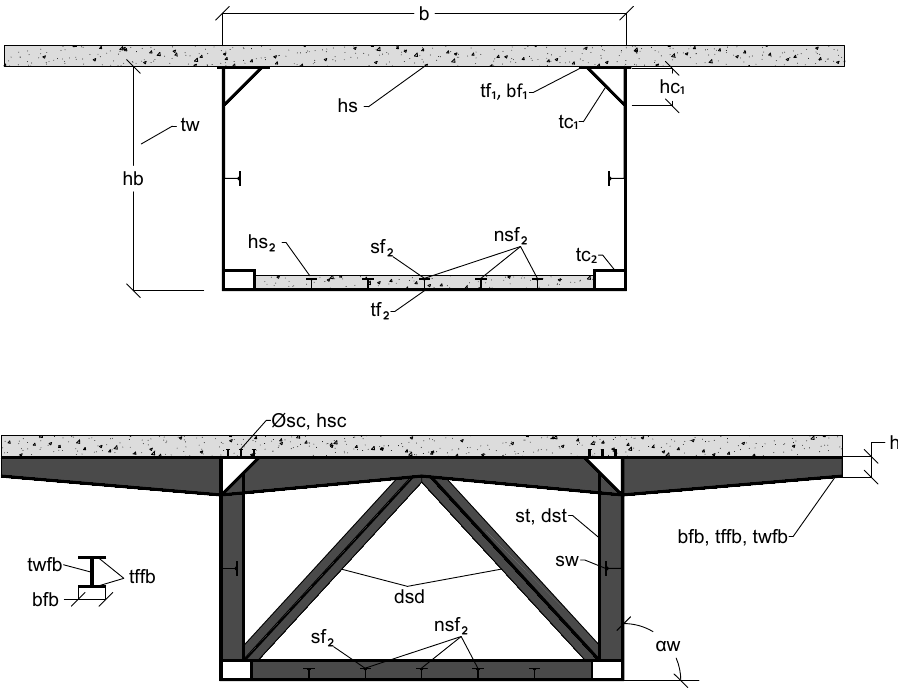
Figure 1. Transverse section variables for the optimization